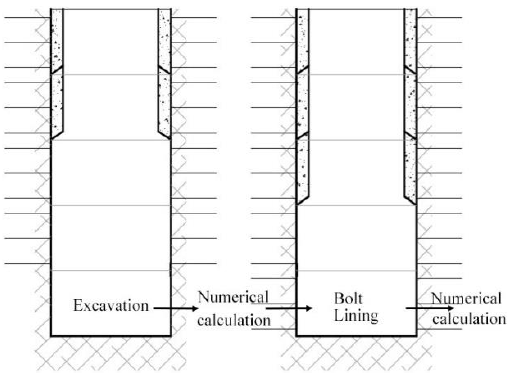
Figure 10. Calculation process of the proposed excavation plan.